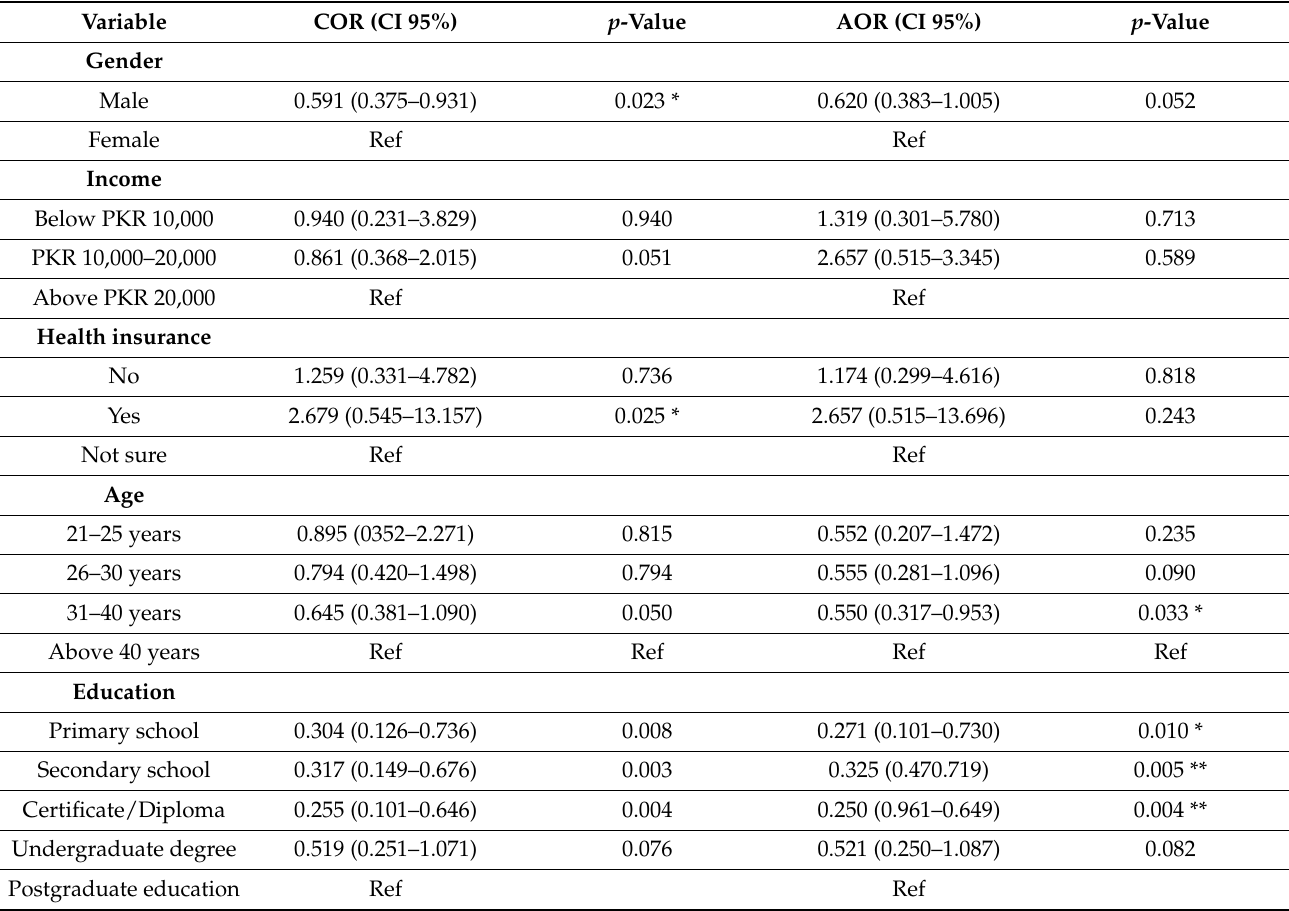
Table 4. Multivariate logistic regression analysis of predictors for